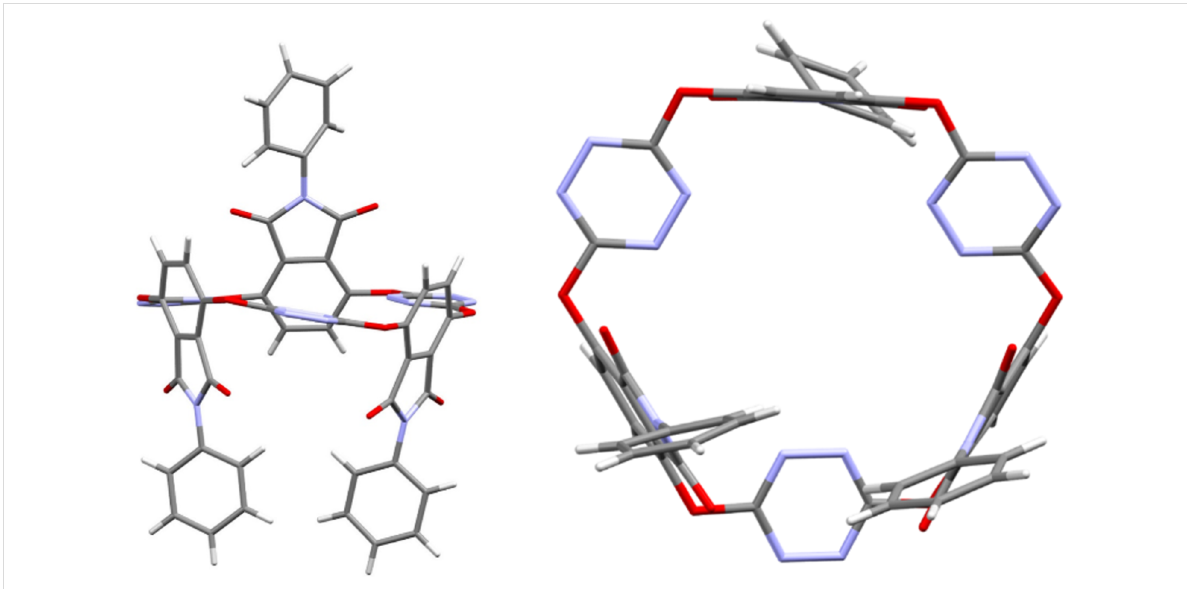
Figure 1: X-ray molecular structure of 3a (CCDC 1913907) with side (left) and top (right) views. All solvent molecules are omitted for